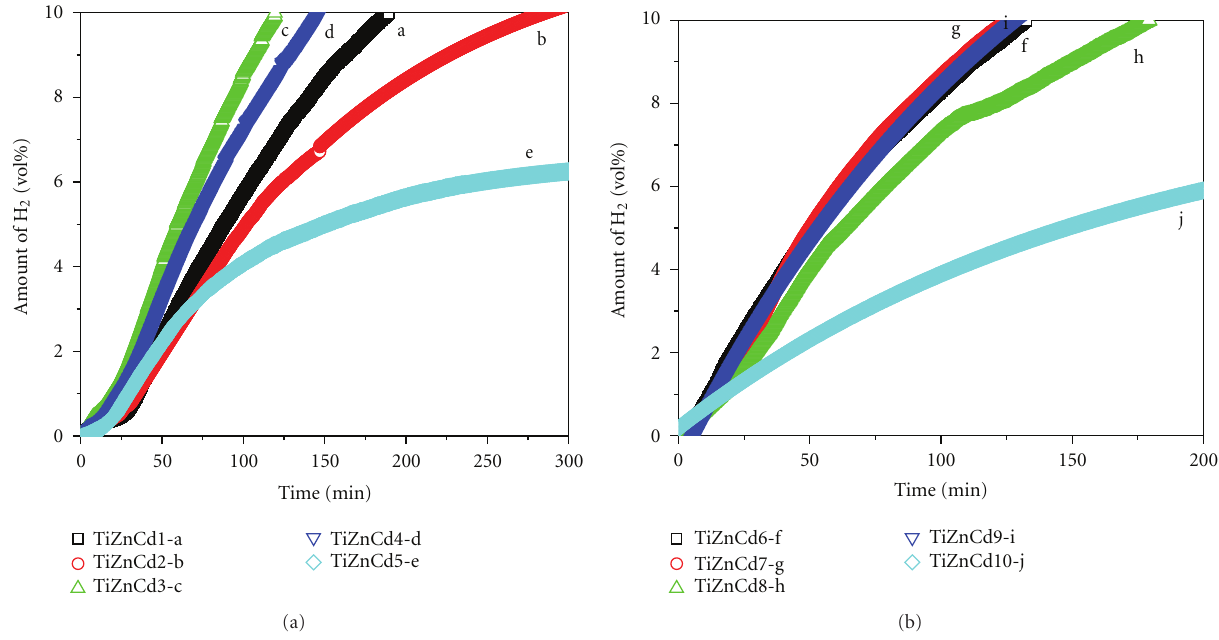
Figure 11: Plot of H 2 evolution on samples series TiZnCd with 1mg Pd